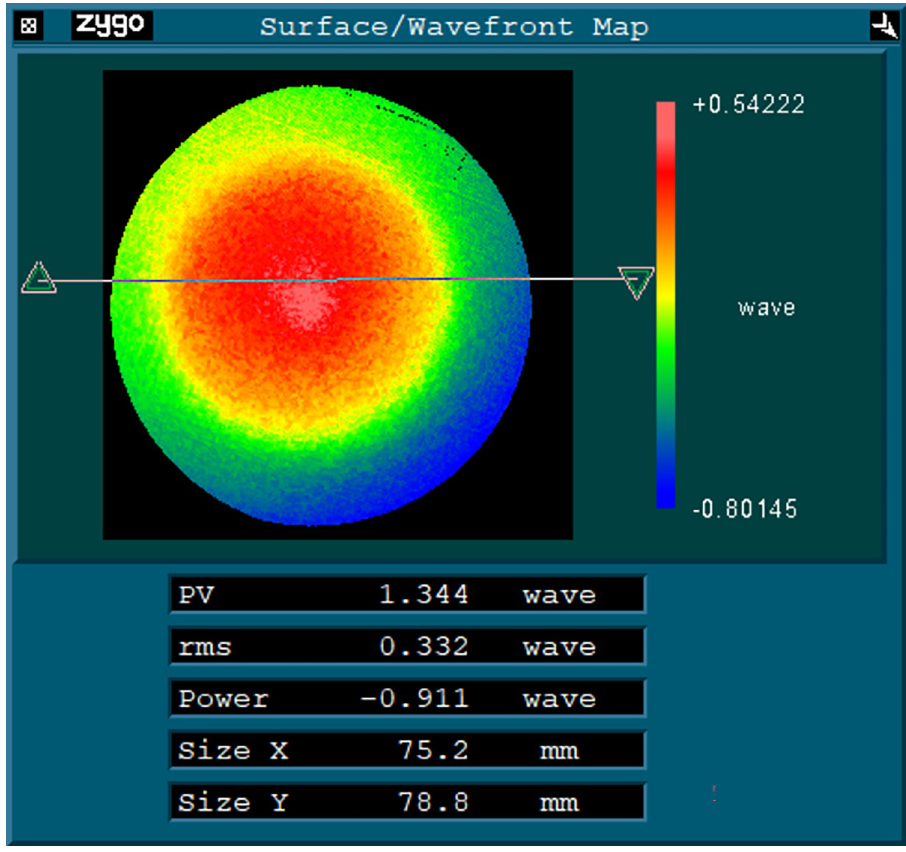
Fig 6. Initial surface error.